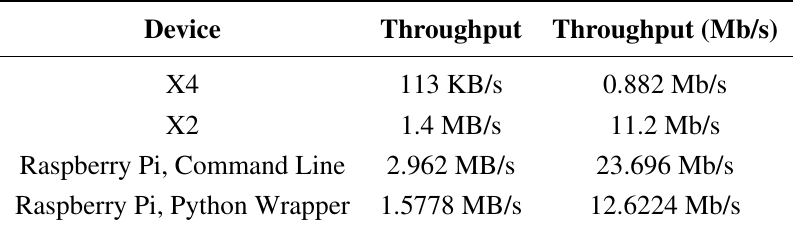
Table 7. Summary throughput results for secure communication